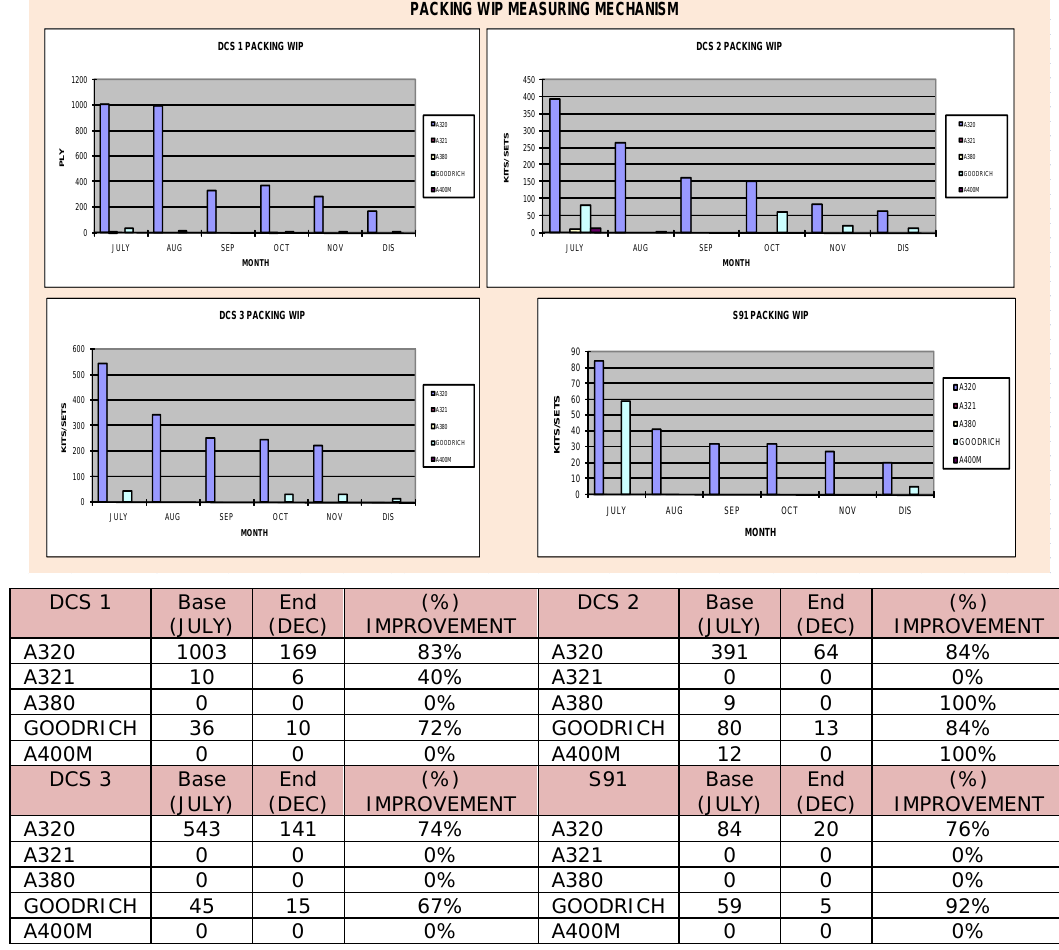
Figure 11. “Percentage of improvement for Packing WIP